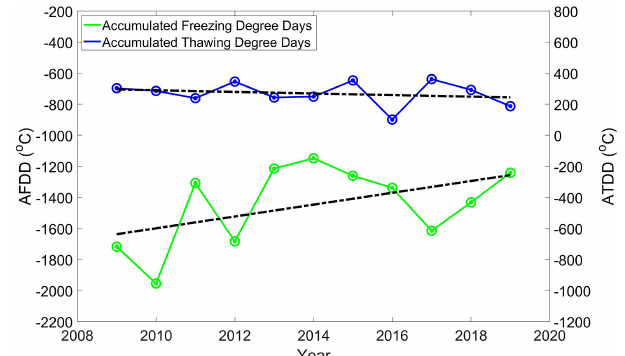
Figure 11. The seasonal accumulated freezing degree day (AFDD) and thaw degree day (ATDD) during the observation period